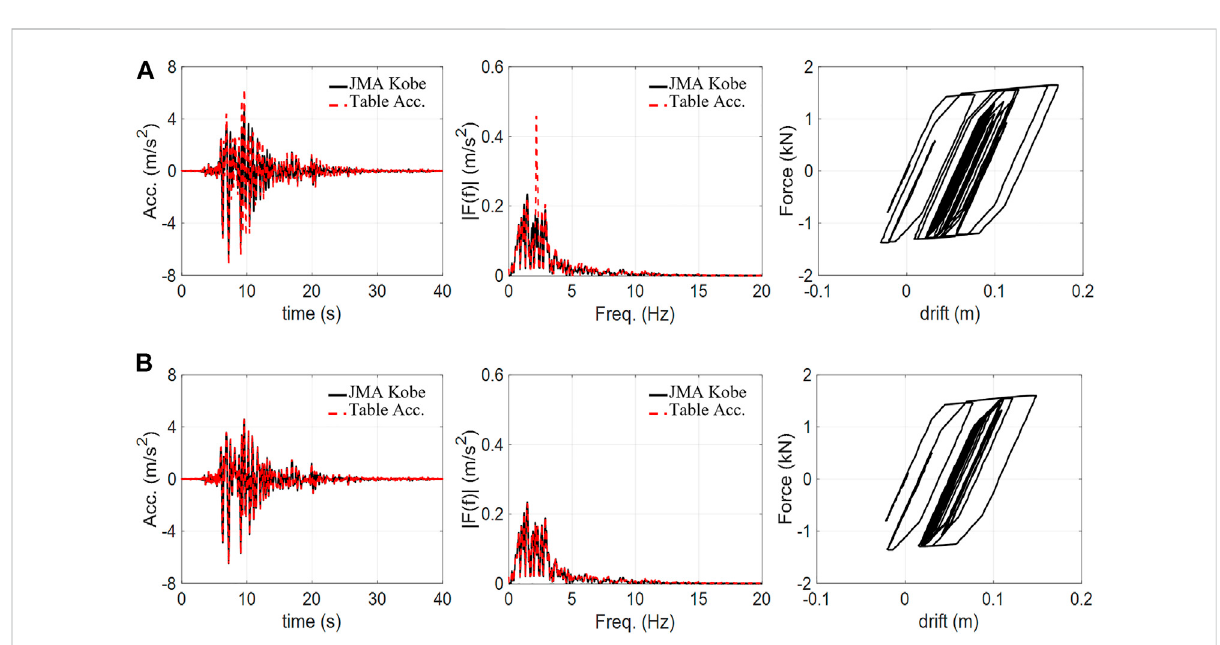
FIGURE 8 Numerical results of a shake table with a nonlinear structure and 80% JMA Kobe motion: (A) IBC and (B) NSBC. (Left: time-history table acceleration, middle: Fourier amplitude spectra of table acceleration, right: structural